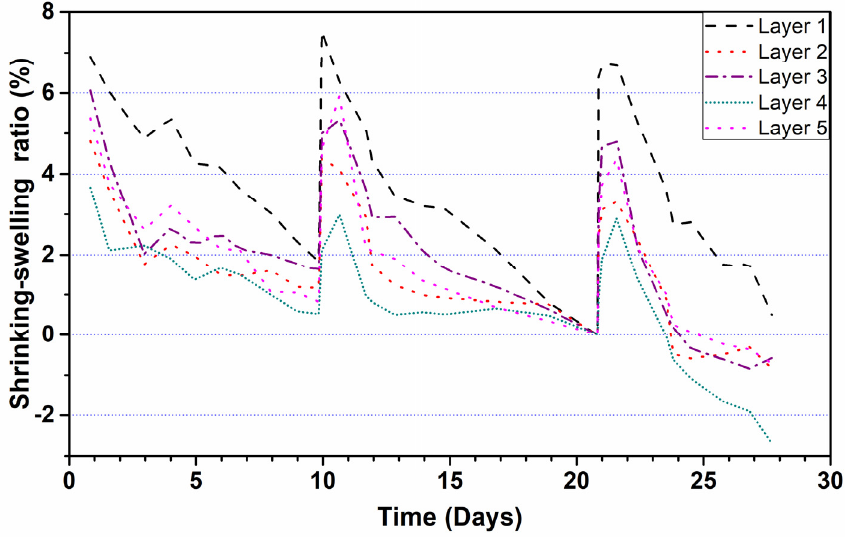
Figure 3. SSR of five layers during 3 dry–wet cycles.